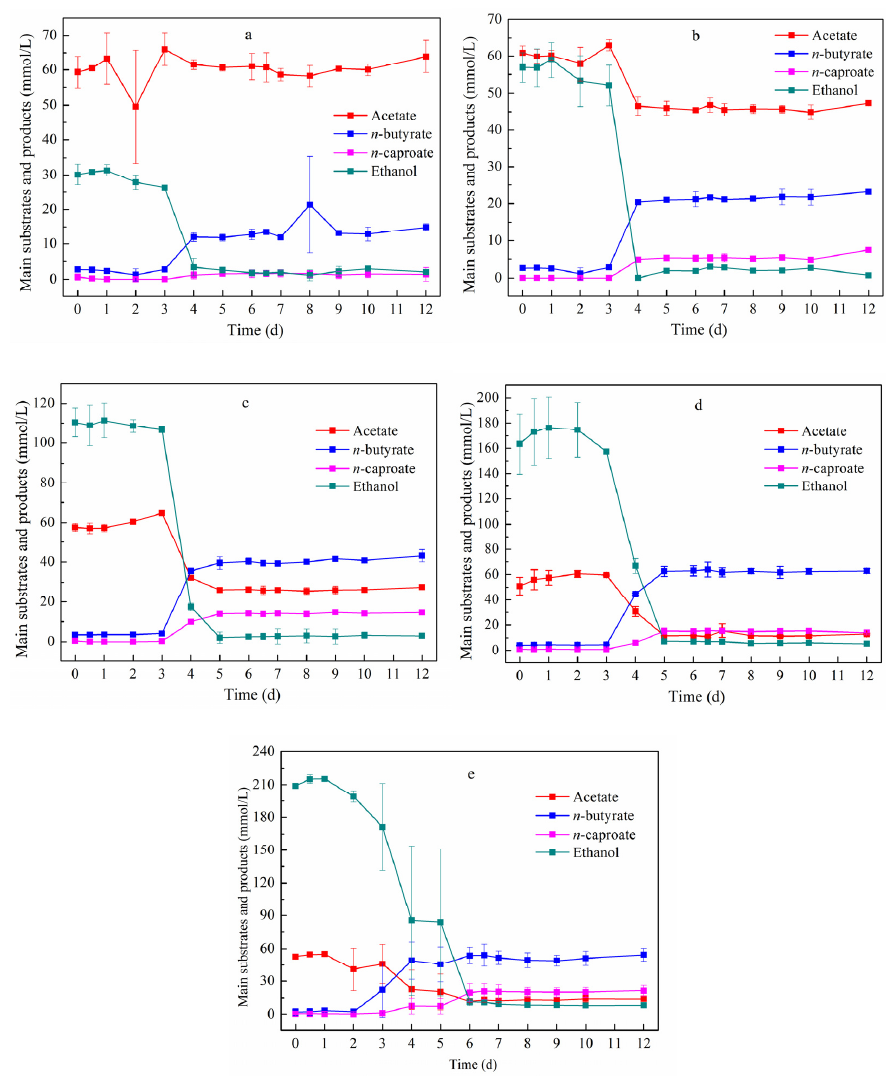
Figure 1. Concentration variation of main substrates and products along chain elongation with acetate / ethanol ratios of 2:1 ( a ), 1:1 ( b ), 1:2 ( c ), 1:3 ( d ), and 1:4 ( e ).